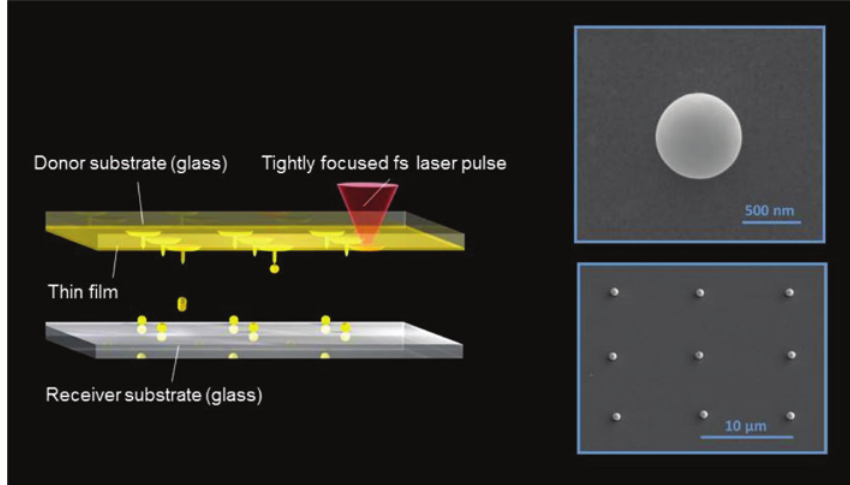
Figure 2: Typical experimental setup for laser printing of nanoparticles is shown on the left side. SEM images of a single printed gold nanoparticle and nanoparticle array are shown at the right